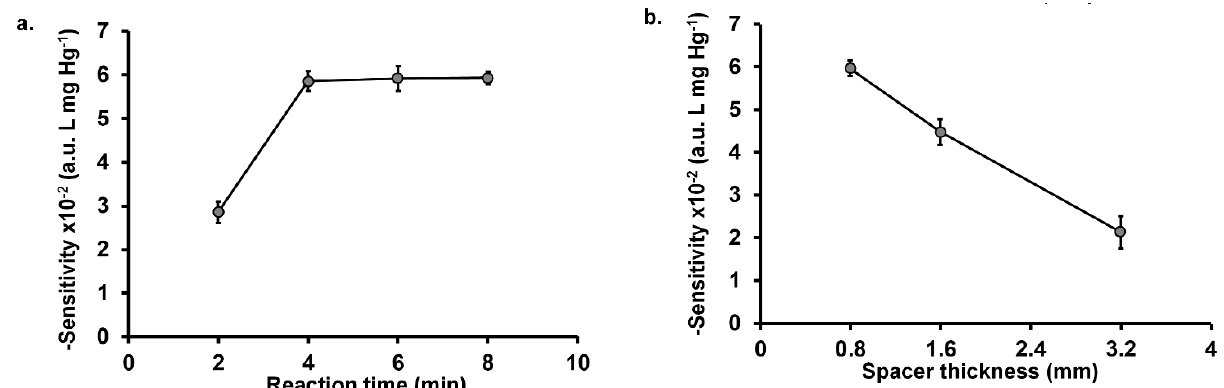
Figure 3. Effect of physical parameters on analysis of Hg(II): ( a ) reaction time and ( b ) spacer thickness. Experimental conditions: 0.2 mol L − 1 KIO 3 in 0.2 mol L − 1 H 2 SO 4 , 10 mmol L − 1 KI and 1% ( w / v ) of starch in 0.1 mmol L − 1 KI. For the spacer thickness study, the reaction time is 4 min .